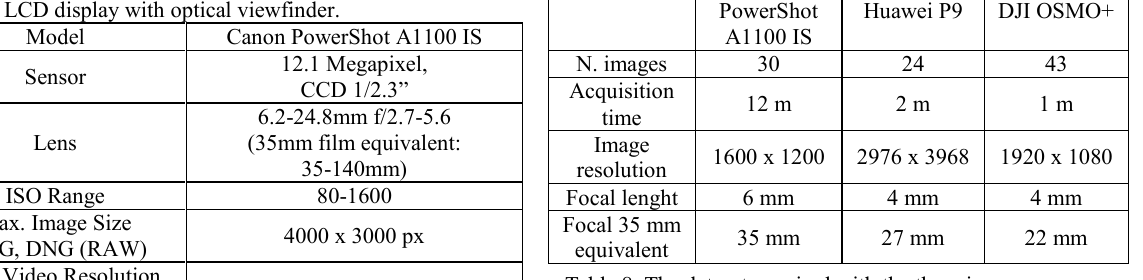
Table 8. The dataset acquired with the three imagery